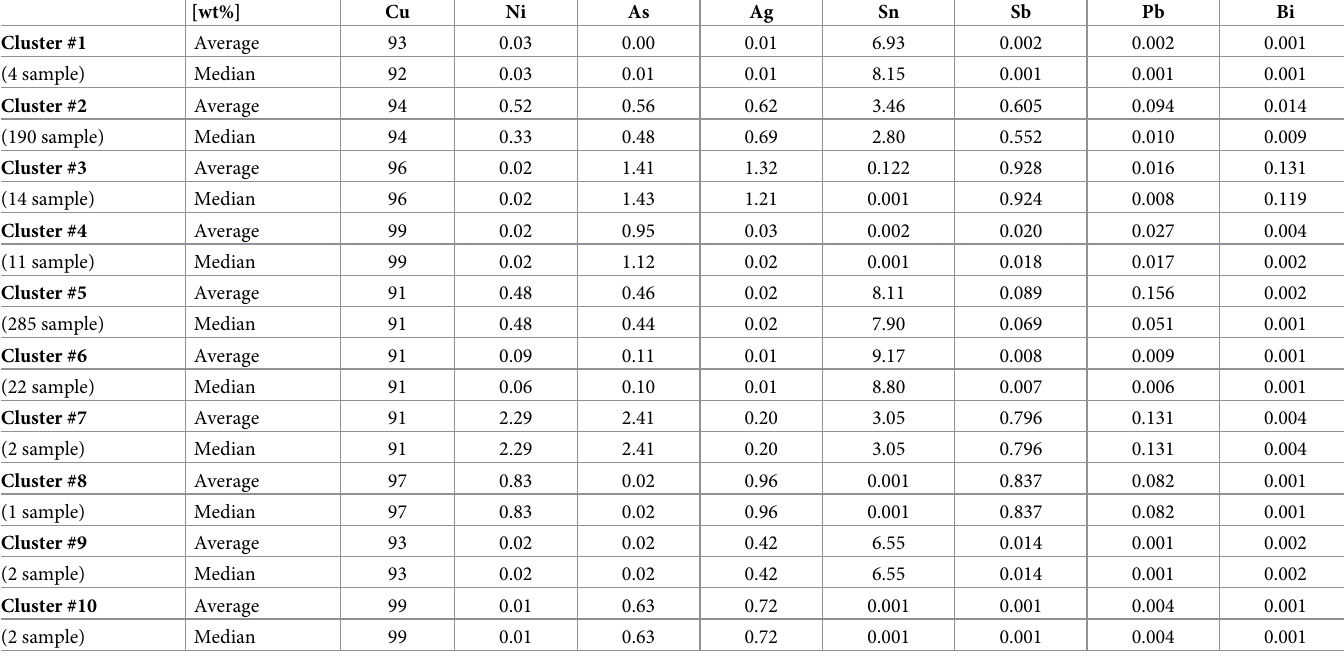
Table 2. Elemental compositions (average) of the ten major clusters discussed in this study.